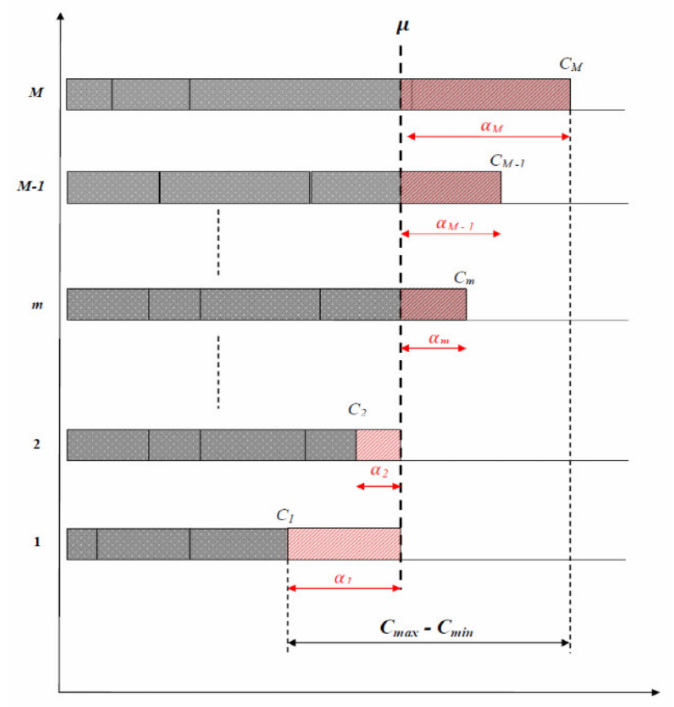
Figure 1. Illustration of the workload imbalance on identical parallel machines. The different notations used in this paper are described below in Table